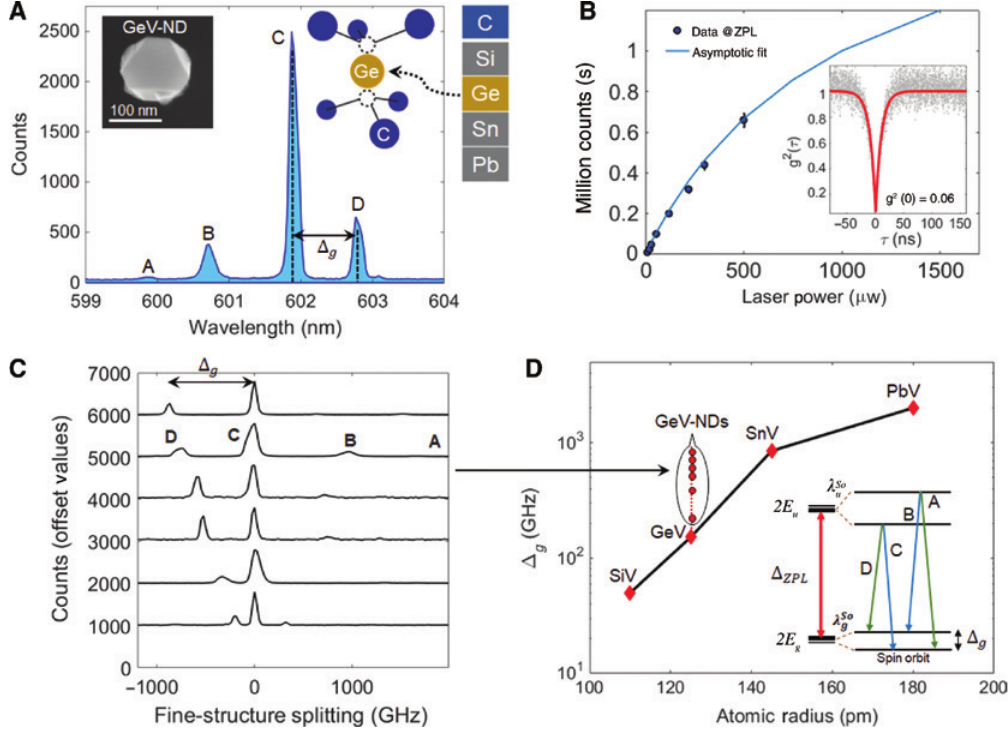
Figure 1: Color centers in diamond crystals with structural symmetries and bright ZPLs. (A, B) Characterization of a single GeV center in an HPHT ND. Spectrum taken at a cryogenic temperature exhibits a four-line fine structure at around 602 nm similar to bulk crystals (A). Inset shows an SEM image of the ND. The temperature of the ND was calculated to be ~ 40 K using Boltzmann statistics [21], which is higher than the temperature of the cryostat cold finger due to the limited thermal conductivity of the substrate (silicon). (B) Power dependency measurements indicates ultrabright ZPLs (exceeding 1 million counts/s at 1 mW). The saturation curve was fitted to an asymptotic function [ I = I · P /( P + P ), where I and P are saturated intensity and saturated power, respectively], ∞ ∞ ∞ ∞ indicating a 15-fold enhancement in brightness compared to those reported for bulk diamonds [22]. Inset shows a strong antibunching dip in autocorrelation measurement [ g 2 (0) = 0.06], which implies single photon emission. The red line represents a single exponential fit [16]. (C, D) Energy splitting in the ground states ( Δ ) for different GeV-ND samples were measured and shown in (C) and compared with other g group IV color centers in diamond (D). (D) The larger atom exhibits larger splitting and a potentially longer spin coherence time. The values of Δ for color centers in bulk diamond, including SiV [19], GeV [16], SnV [17], and PbV [18], were adapted from the experimental results g reported for the corresponding vacancies. Having GeV centers in NDs results in even larger energy splitting in the ground state [up to 870 GHz as shown in (C)] due to the strain conditions in nanocrystals. Inset shows zero-phonon optical transition lines for a typical group IV color center. Internal transitions of B and C are parallel in polarization and orthogonal to the external transitions of A and D, resulting in an emitter with two orthogonal dipoles [19,